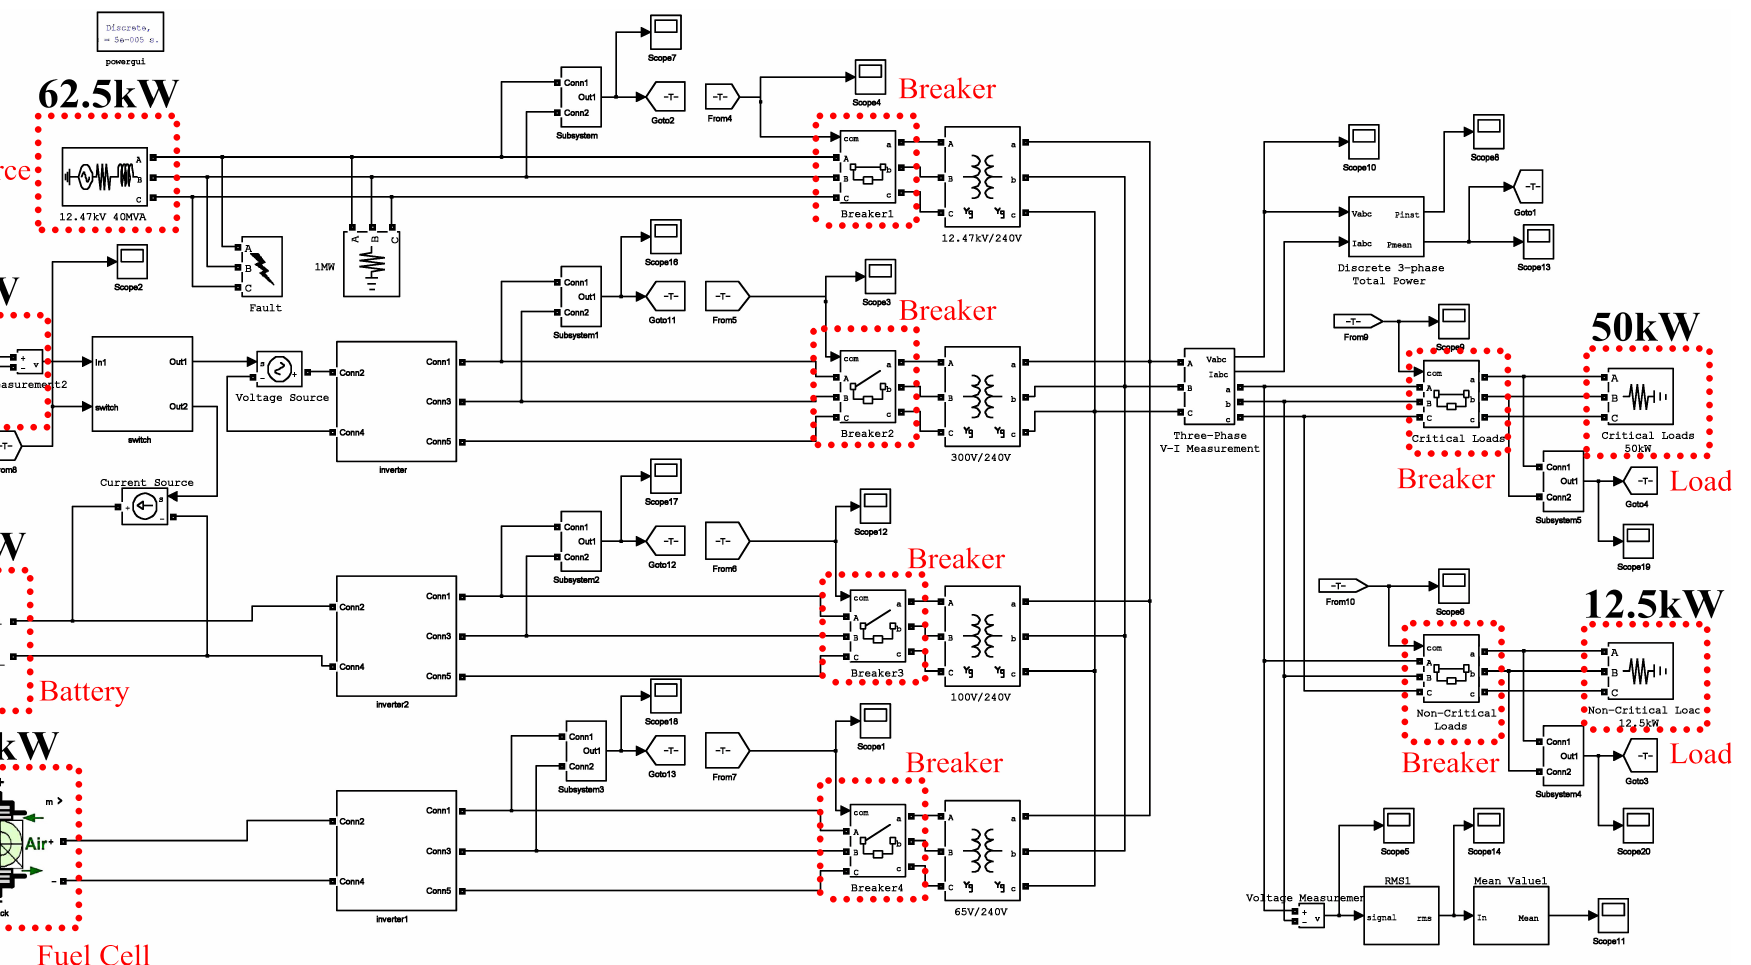
Figure 7. Simulink circuit diagram of the